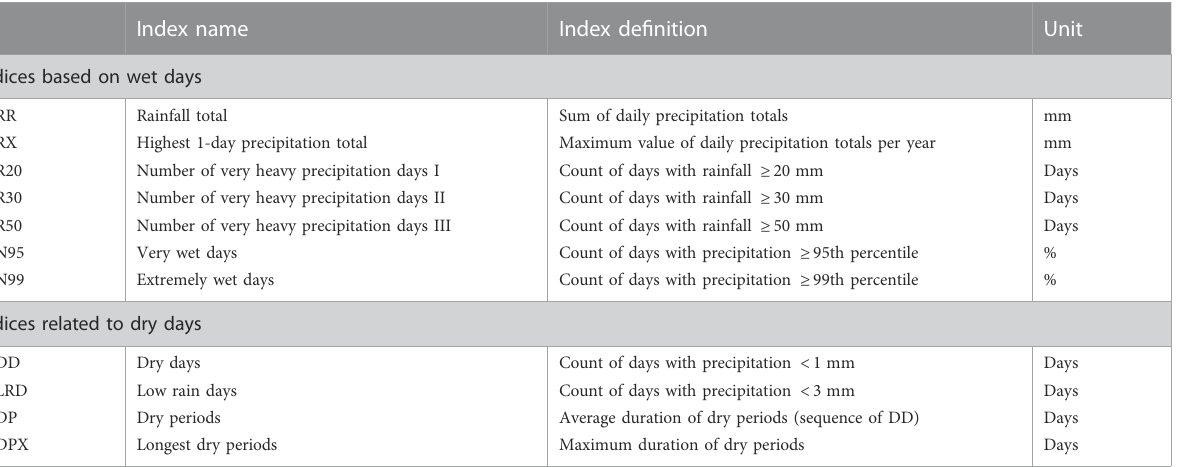
TABLE 1 Description of precipitation indices based on wet and dry